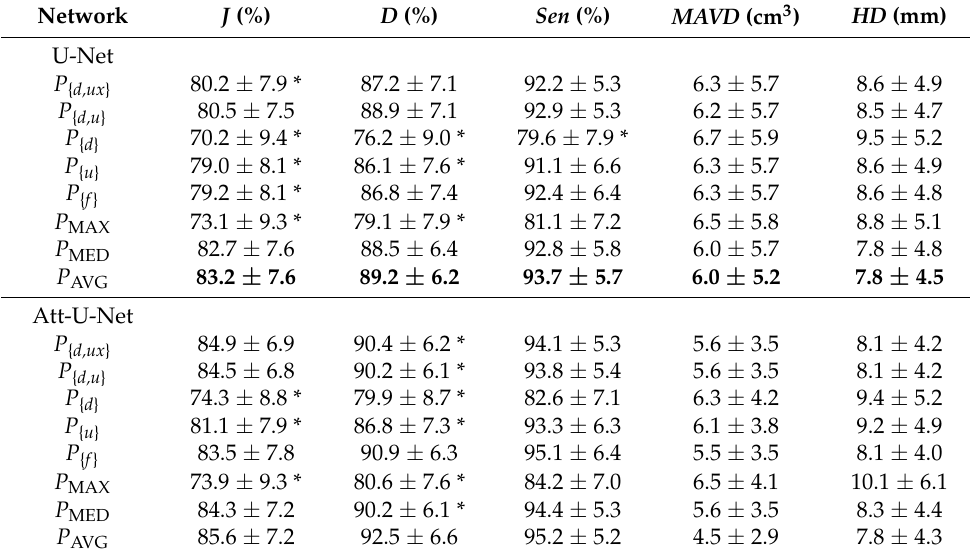
Table 3. Average quantitative results (mean ± standard deviation) from 200 normal cases employing the SIMO approach to the U-Net and Att-U-Net with three-fold cross-validation. Bold typeface indicates the best performing method for each metric. * indicates a significant difference with respect to the P AVG score after performing a Nemenyi